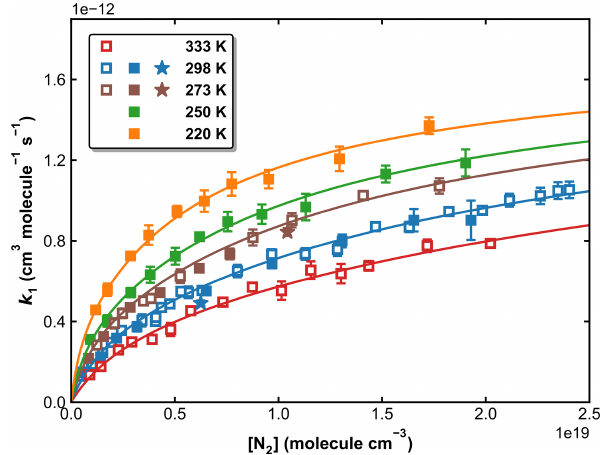
Figure 9. k 1 as a function of N 2 concentration in the fall-off regime at five different temperatures. Open squares, closed squares, and stars represent data obtained using H 2 O 2 , HNO 3 , and HONO as OH precursors, respectively. The error bars represent 2 σ statis- tical uncertainties. The solid lines are the fits of the experimen- = 3 . 03 × 10 − 31 cm 6 molecule − 2 s − 1 tal data to Eq. (3) with k N 2 1 , 0